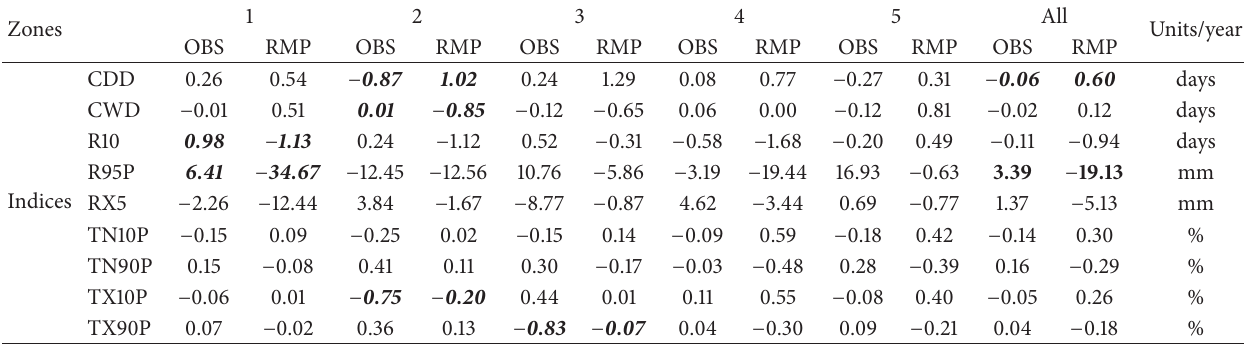
Figure 2: Temporal and spatial variability of consecutive dry days (CDD). Graphs show average time series for each zone for observation (red), PRECIS-reanalysis (green), and reanalysis matching points (purple) for 1979–1989. Correlation coefficients between the observation time series and each reanalysis time series are noted with values in bold indicating statistical significance at the 95% level. Maps of observed trends (left) and PRECIS-reanalysis trends (right) for 1979–1989 are shown in the bottom panel. Trend units are days/year. Brown colour indicates negative and green colour indicates positive trends. Statistically significant trends are indicated with white stippling. Table2:Lineartrendscalculatedover1979–1989forstationobservations(OBS)andPRECIS-reanalysismatchingpoints(RMP)forallindices across each zone and the entire Caribbean. Trend values with differences that are statistically significant at the 95% level are in bold and italics. CDD (CWD) is the maximum number of consecutive dry (wet) days; R10 is the annual count of days when precipitation is greater than or equal to 10mm; R95P is the annual total precipitation when rainfall is greater than the 95th percentile; RX5 is annual highest 5-consecutive- day precipitation (mm); TX90 (TN90) is the percentage of days when maximum (minimum) temperature is greater than the 90th percentile; TX10 (TN10) is the percentage of days when maximum (minimum) temperature is less than the 10th